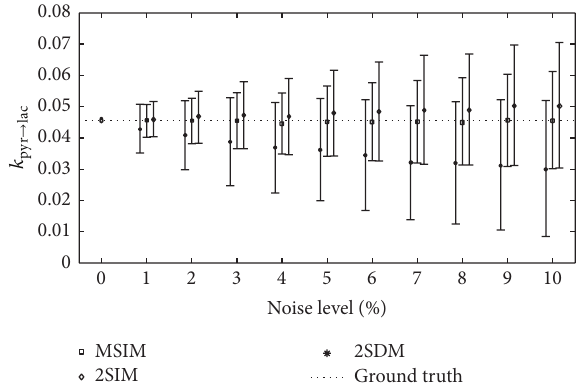
Figure 3: Noise level analysis for exemplary simulated data. Error bars show mean ± standard